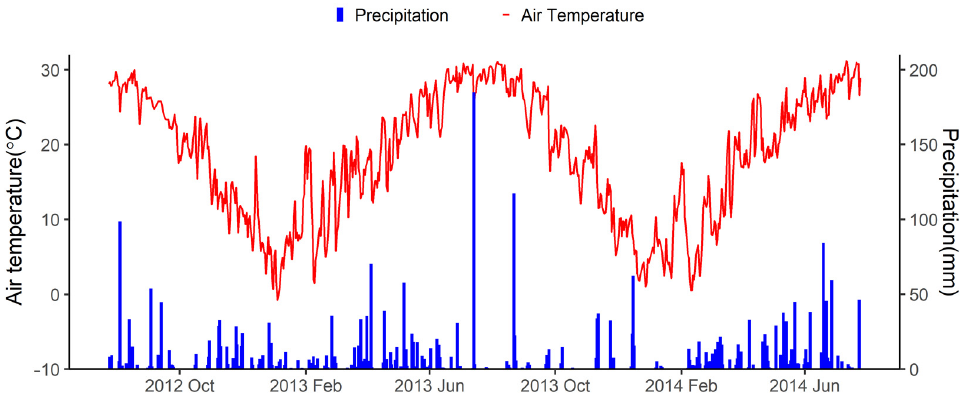
Figure 1. Daily air temperature and precipitation from 2012 to 2014 at the Qingyanzhou Ecological Research Station, south China.